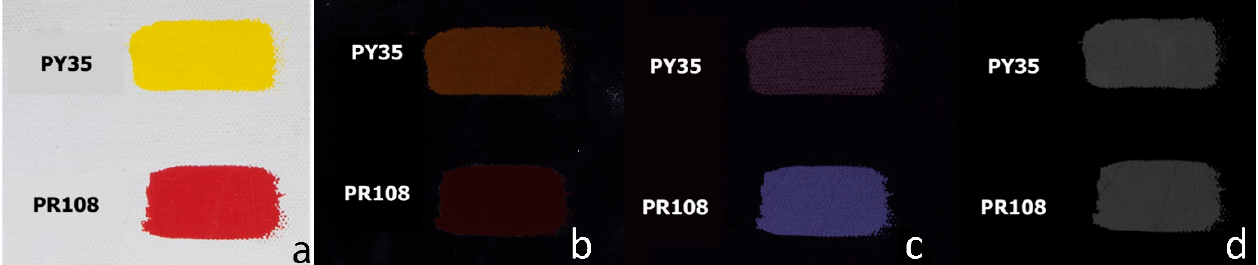
Figure 10. ( a ) Visible image of painting layers on canvas containing cadmium yellow PY35 and cadmium red PR108 in linseed oil; ( b ) UVF image; ( c ) VIVF image with λ exc 530 nm, λ acq > 720 nm; ( d ) VIL image obtained by 440 nm excitation light.